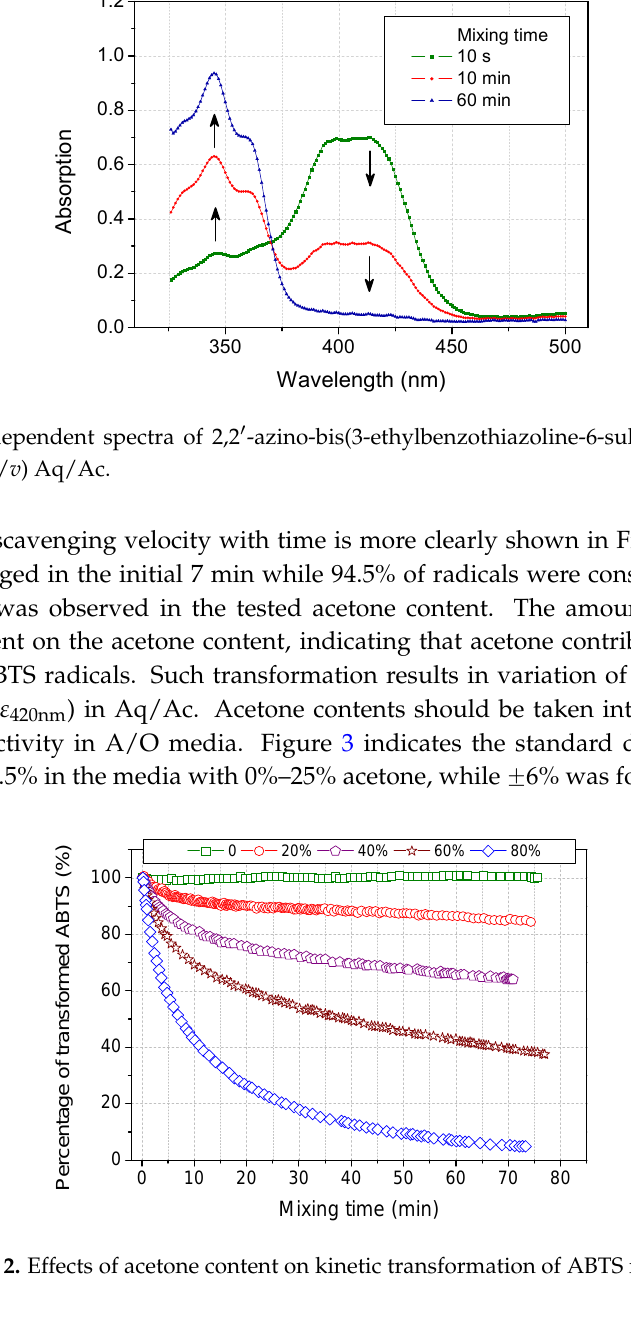
Figure 2. Effects of acetone content on kinetic transformation of ABTS radicals.